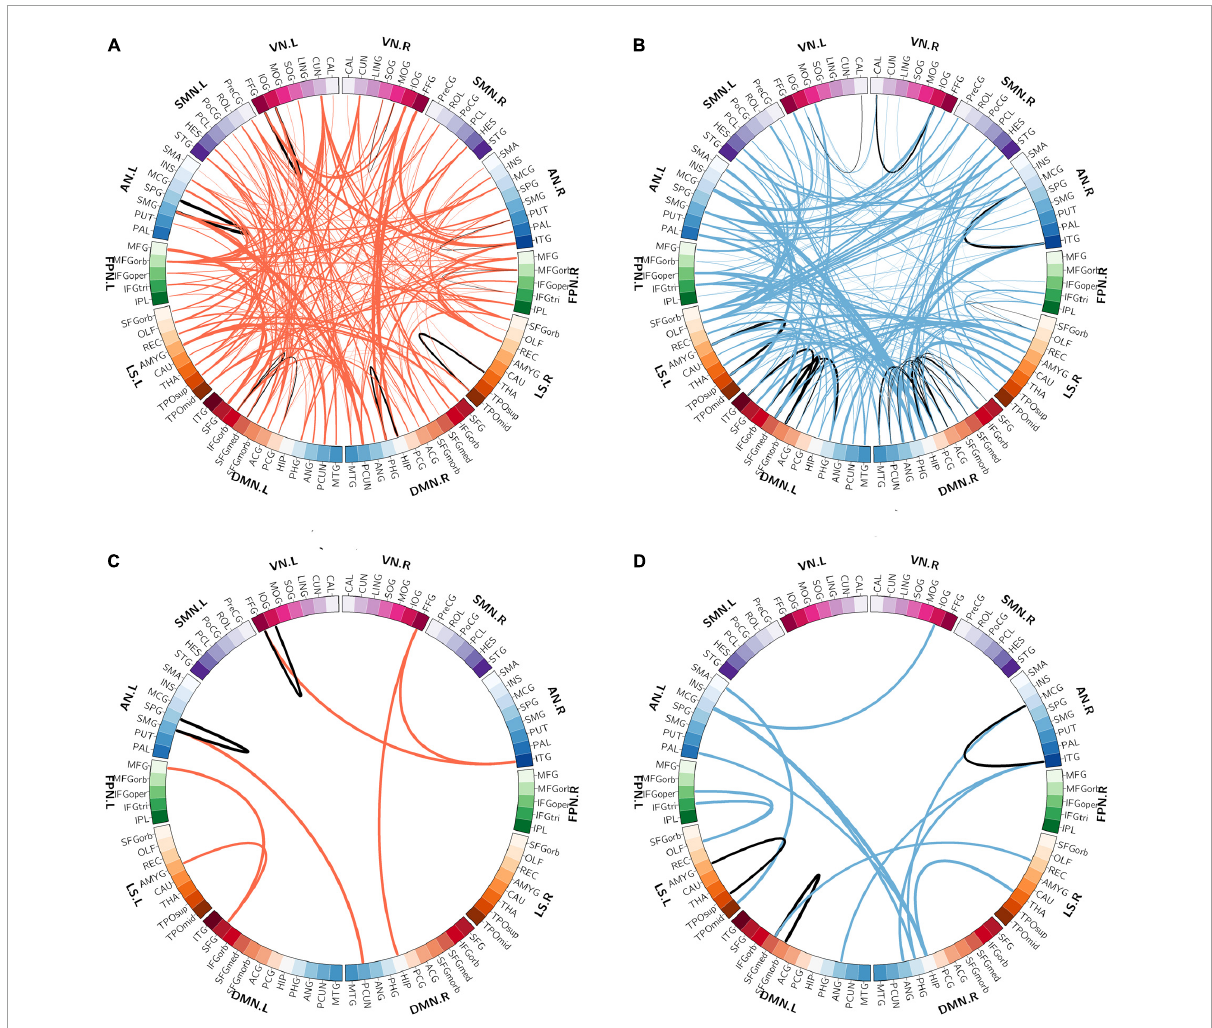
FIGURE2 The spatial distribution of the selected functional connectivity. (A) The spatial distribution of the selected FCs with higher classification weights in patients with OSA compared with controls. (B) The spatial distribution of the selected FCs with lower classification weights in patients with OSA compared with controls. (C) The FCs with higher positive weight values were greater than mean + 2SD in patients with OSA. (D) The FCs with more negative weight values, which means the absolute weight values were more than mean + 2SD in patients with OSA. The thickness of lines represents the absolute weight values and the black lines indicated functional connectivity within one functional network.SD, standard deviation; VN, visual network; SMN, somatomotor network; AN, attention network; FPN, frontoparietal network; DMN, default mode network; LS, limbic